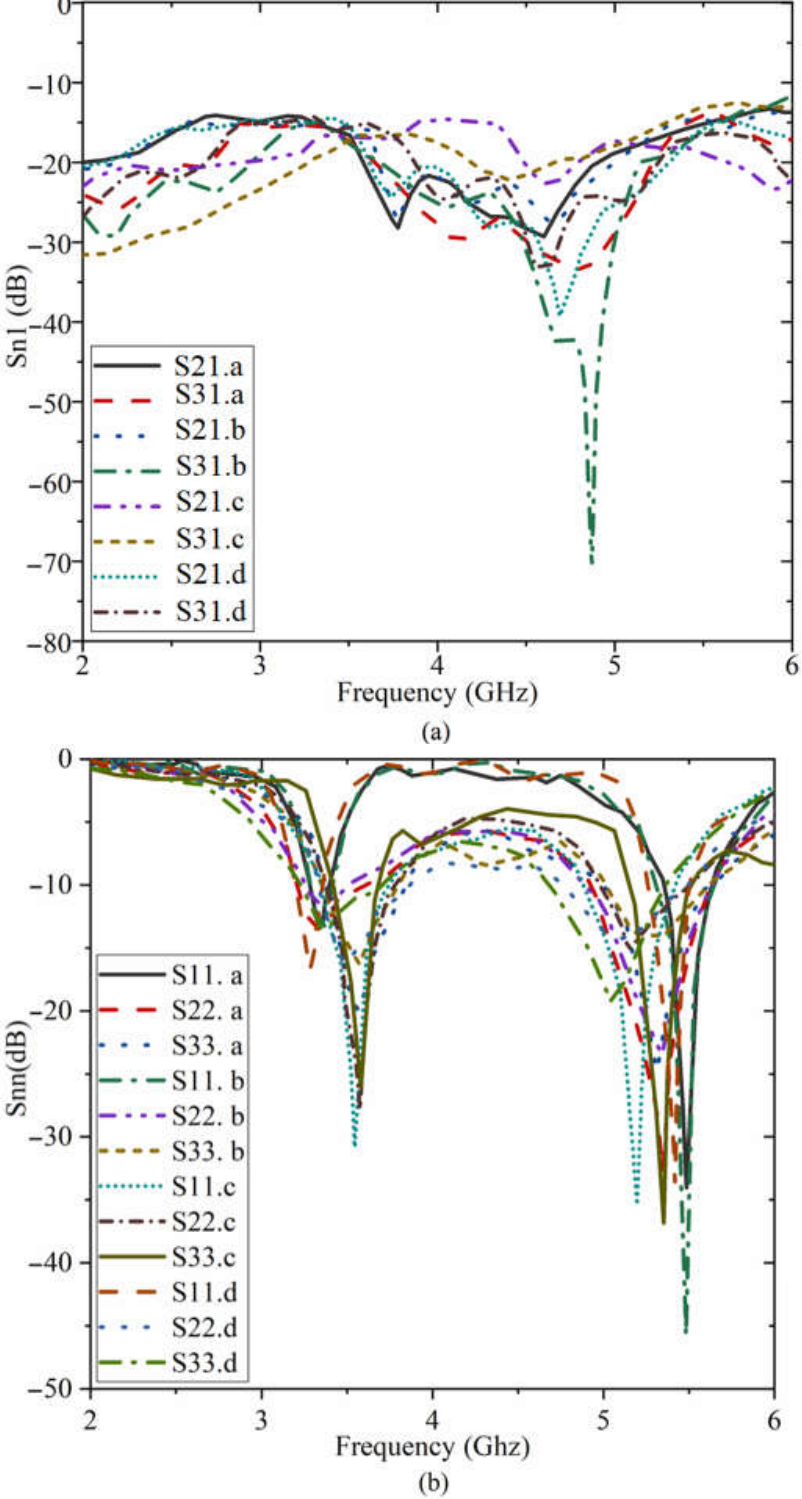
Figure 20. The robustness investigation of the proposed antenna in terms of S-parameters (( a ) transmission coefficient results, ( b ) reflection coefficient results).